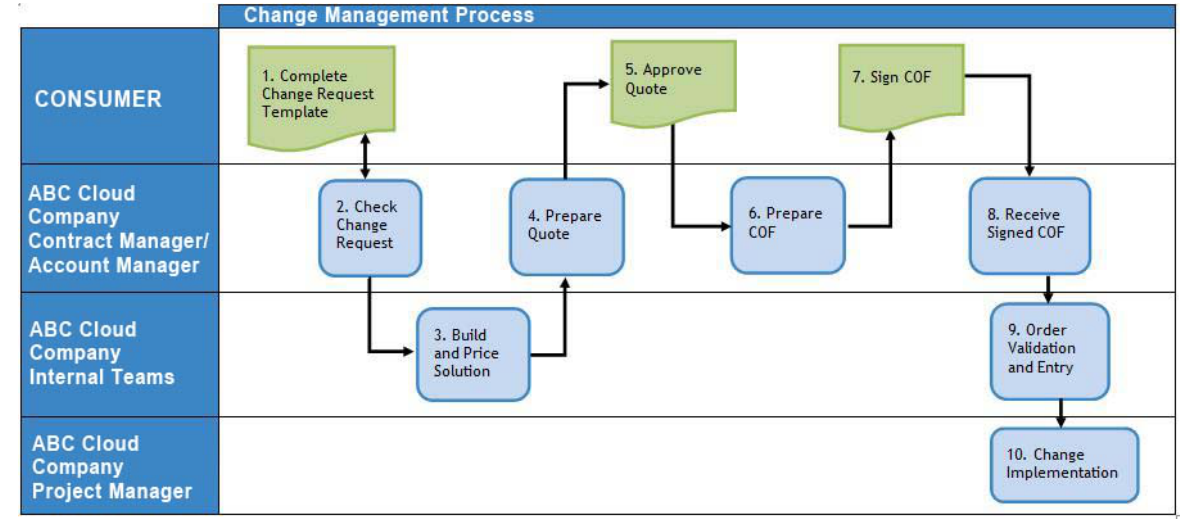
Figure 9. Change